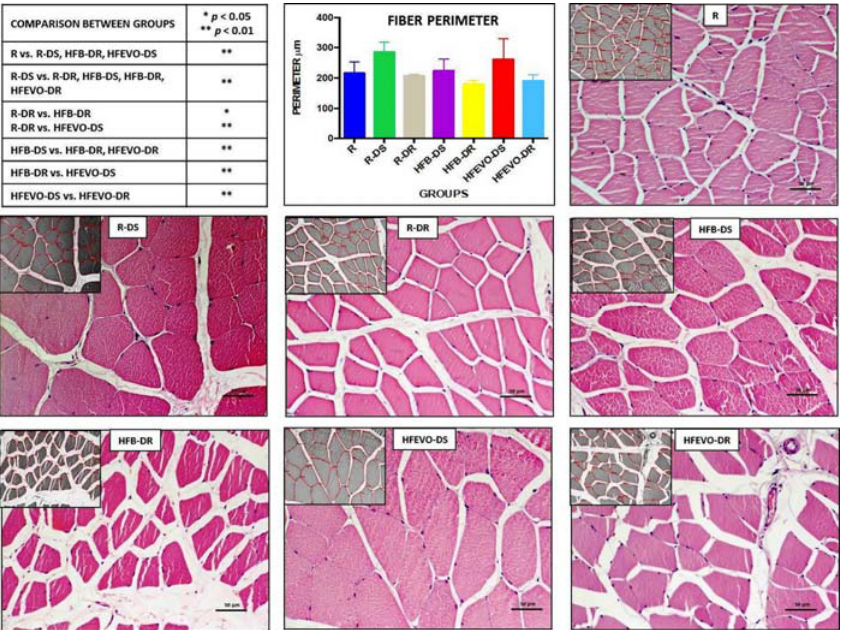
Figure 2. Hematoxylin & Eosin staining. Image analysis by software with morphometric analysis of the perimeter ( μ m) of the muscle fibers (inserts) and a graph representing the mean values of the perimeter ( μ m) in each group with statistical analysis ( p ‐ values in the table). For details, see the text. The data are presented as mean ± SD. Scale bars: 50 μ m.